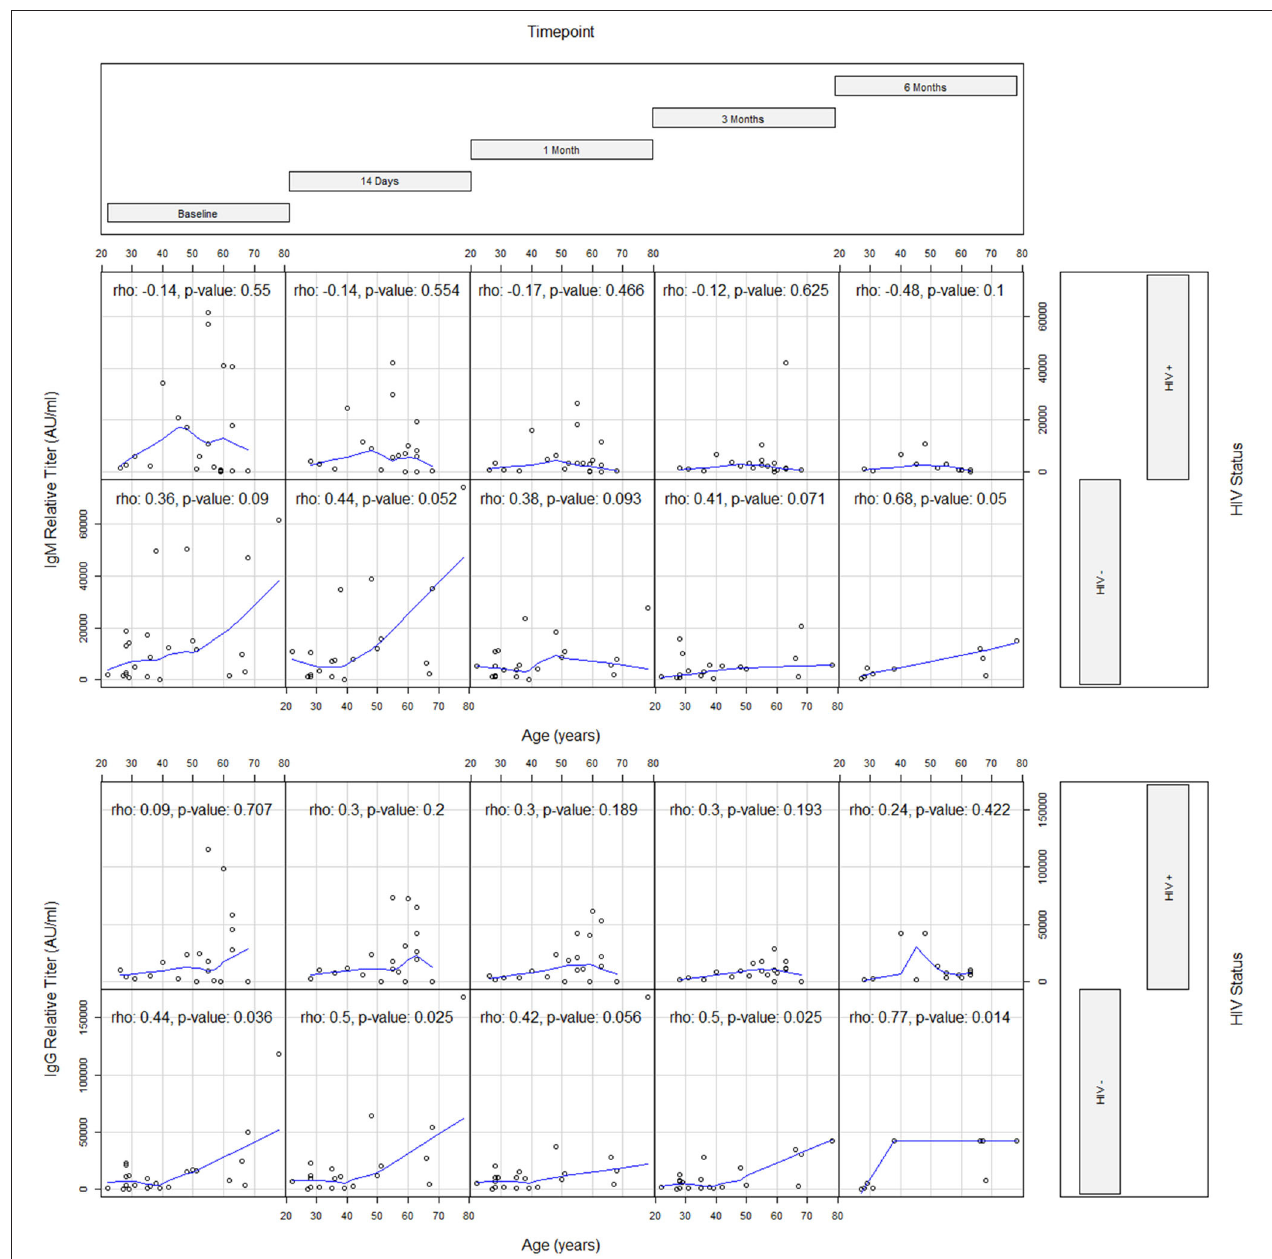
FIGURE 2 | Coplots evaluating the correlation between age and antibody response by timepoint and HIV